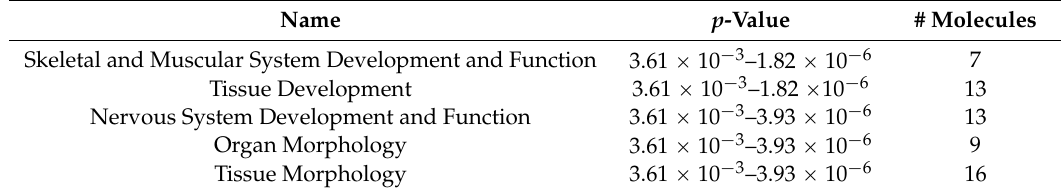
Table 3. Physiological System Development and Function for LAP1 interactors dataset.